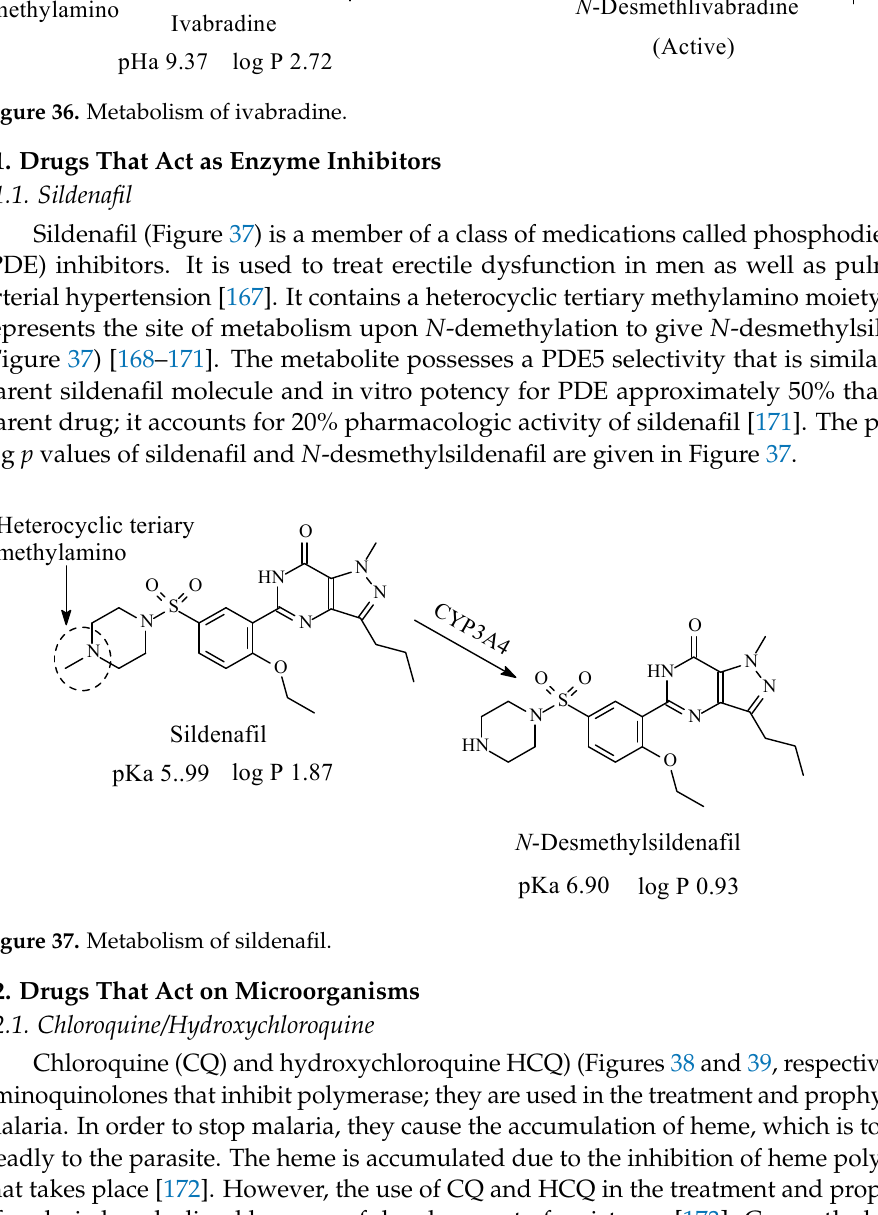
Figure 36. Metabolism of ivabradine.